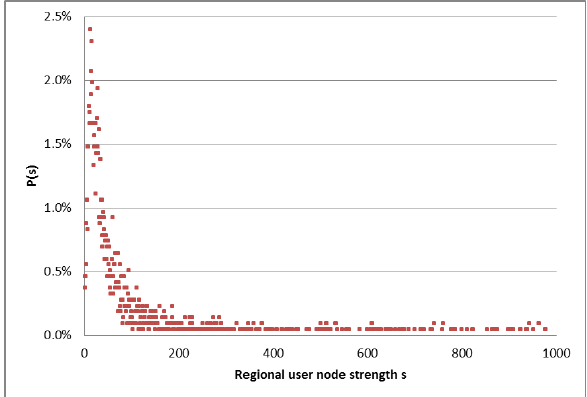
Figure 4. Regional user node strength distribution of the